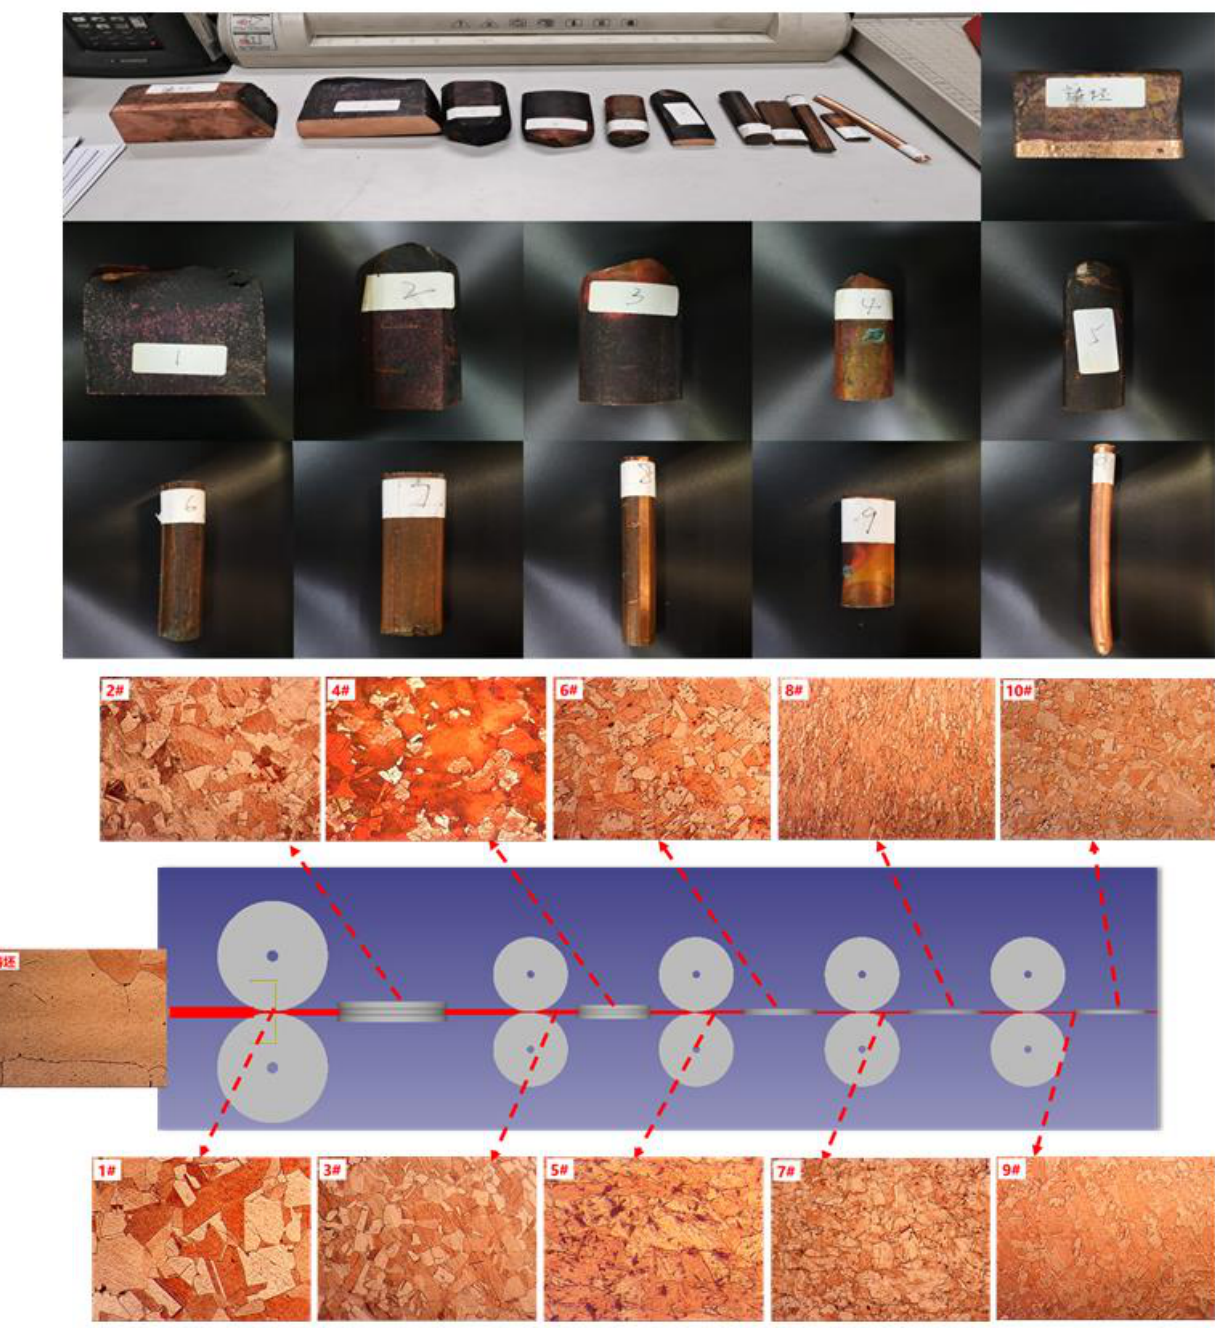
Figure 10. Microstructure and morphology of rolled copper rods in different passes.